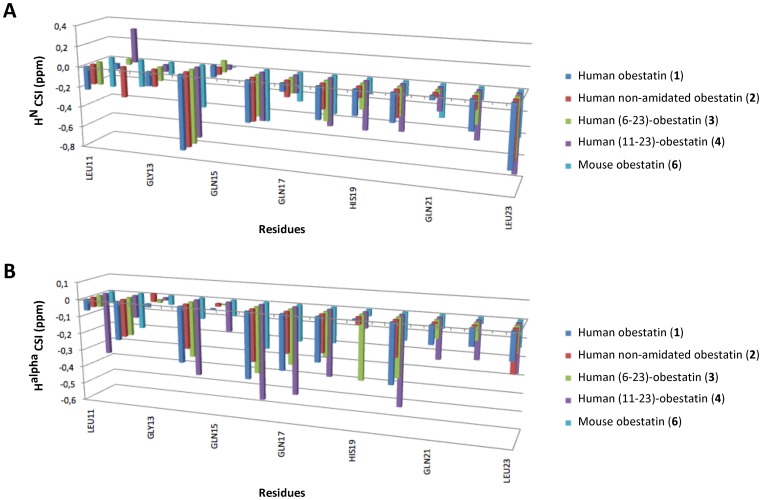
Plot of the chemical shifts indices (CSIs) for residues at the C-termini of the studied peptides.(A) CSIs of the backbone amide protons (HN) and (B) CSIs of the alpha protons (Halpha). The peptide sequence (6) is aligned with that of the other peptides. The CSI is defined as δobs – δrandom-coil.